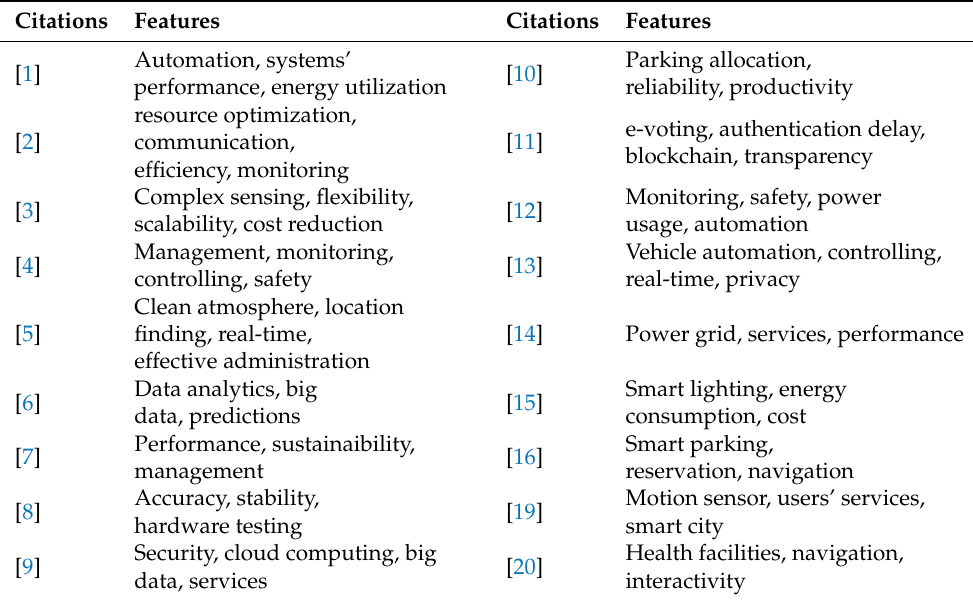
Table 1. Extracted